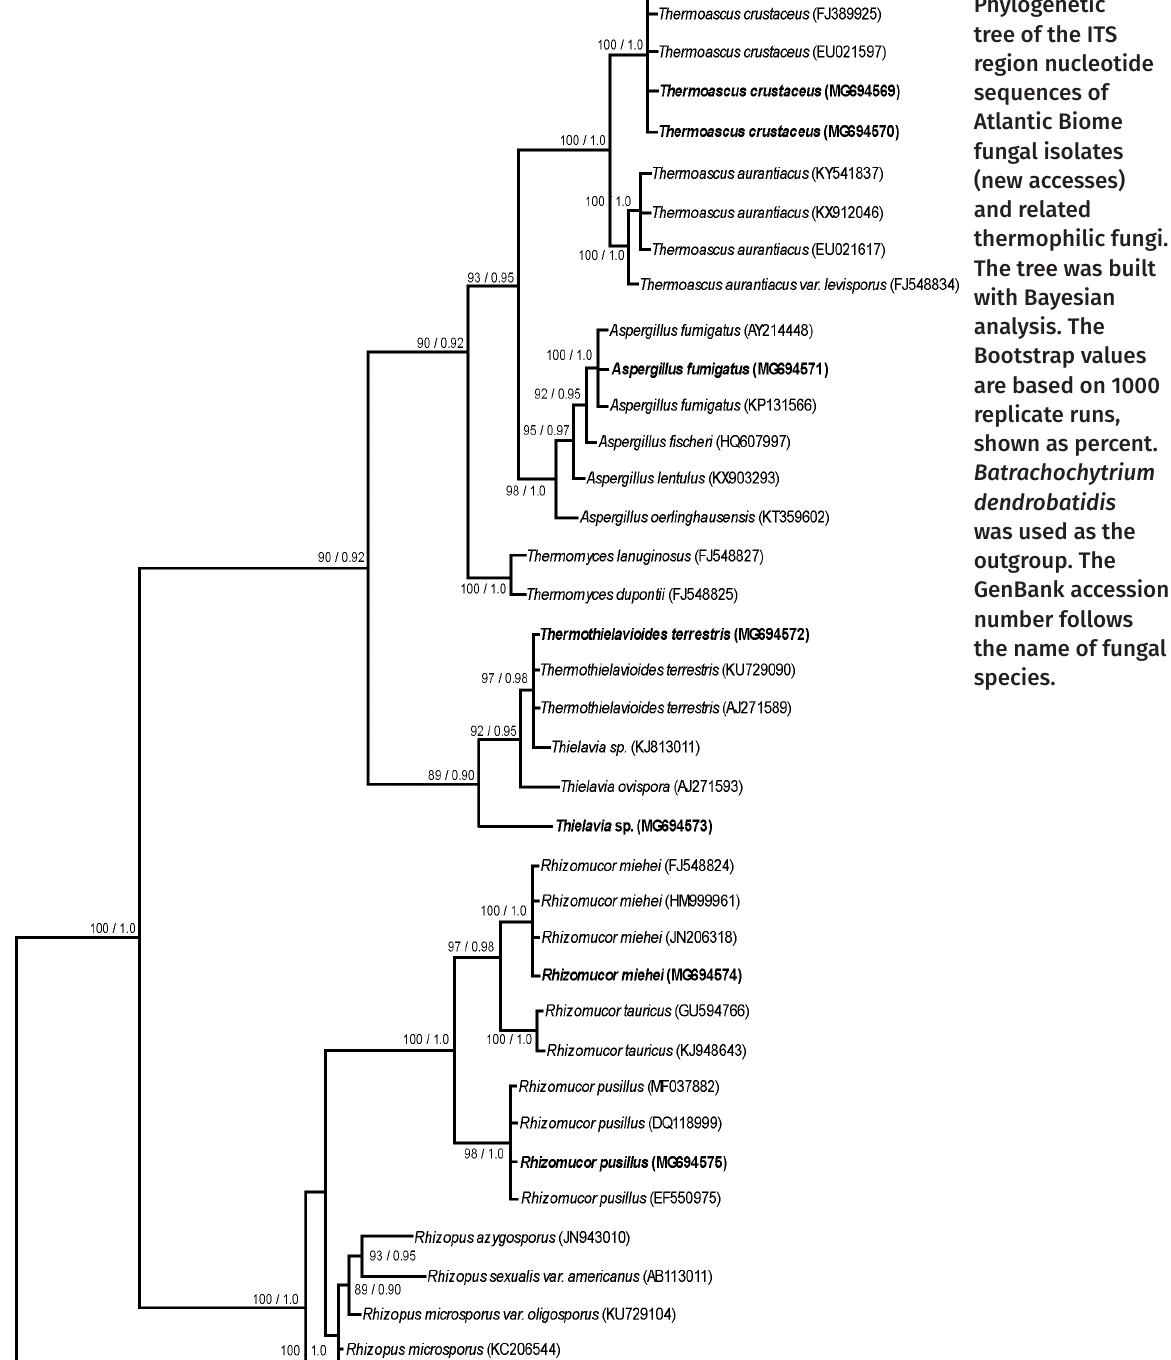
Figure 1. Phylogenetic tree of the ITS region nucleotide sequences of Atlantic Biome fungal isolates (new accesses) and related thermophilic fungi. The tree was built with Bayesian analysis. The Bootstrap values are based on 1000 replicate runs, shown as percent. Batrachochytrium dendrobatidis was used as the outgroup. The GenBank accession number follows the name of fungal